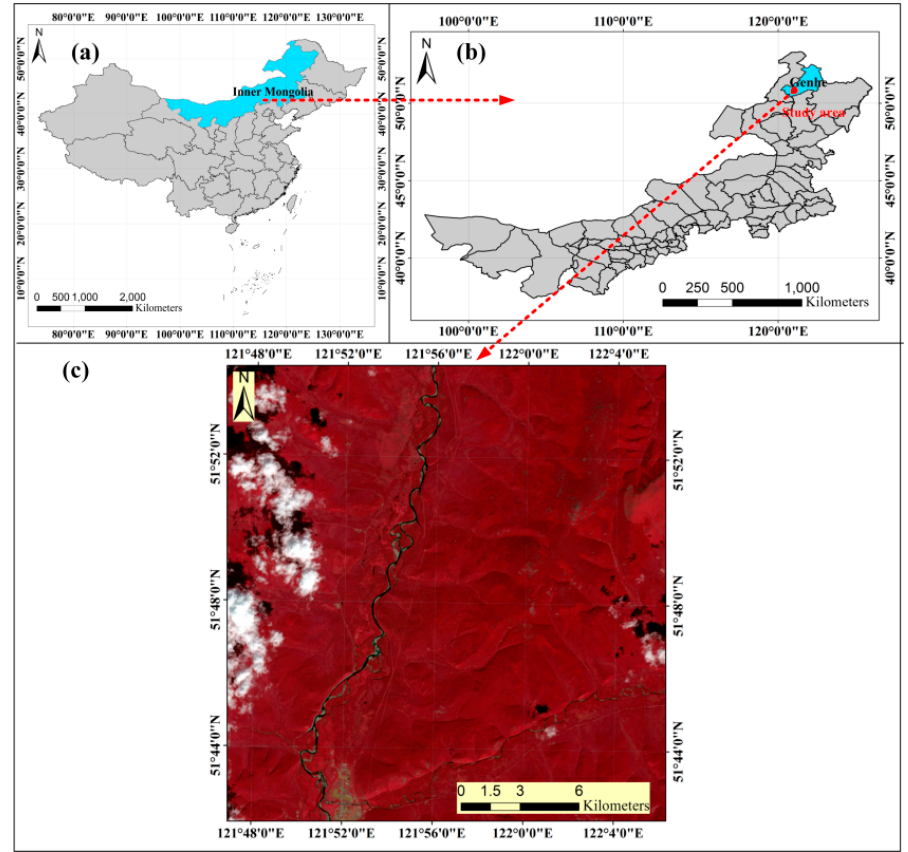
Figure 1. The study area. ( a ) The location of Inner Mongolia Autonomous Region in China; ( b ) The administrative boundary of Genhe in Inner Mongolia Autonomous Region, and the location of the study area in Genhe; ( c ) Landsat 8 OLI image (band 5, 4, 3 false color combination;8% cloud cover) acquired on 25August 2013 of the study area.